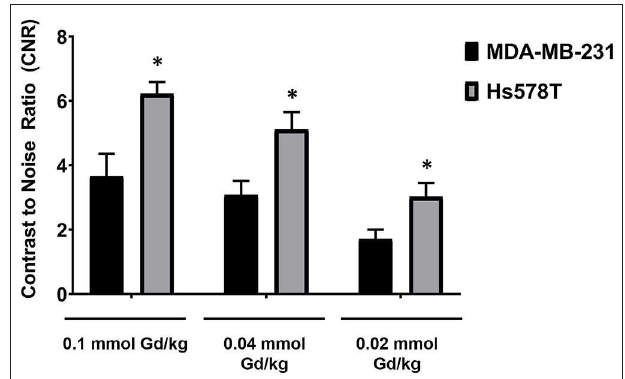
FIGURE 5 | Analysis of tumor signal-to-noise ratio (SNR) at 20min post-injection of MT218 at doses of 0.1, 0.04, and 0.02 mmol Gd/kg mouse. Data is represented as mean ± s.e.m. n = 5 for MDA-MB-231 and Hs578T tumors. * p < 0.05 for comparison of increased SNR